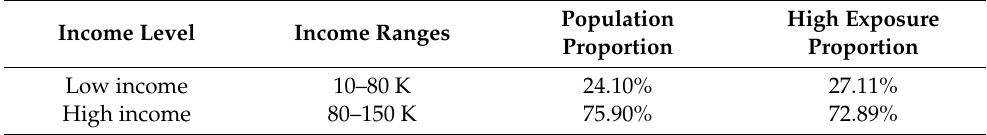
Table 4. The portion of students from an income level vs. their portion of a higher